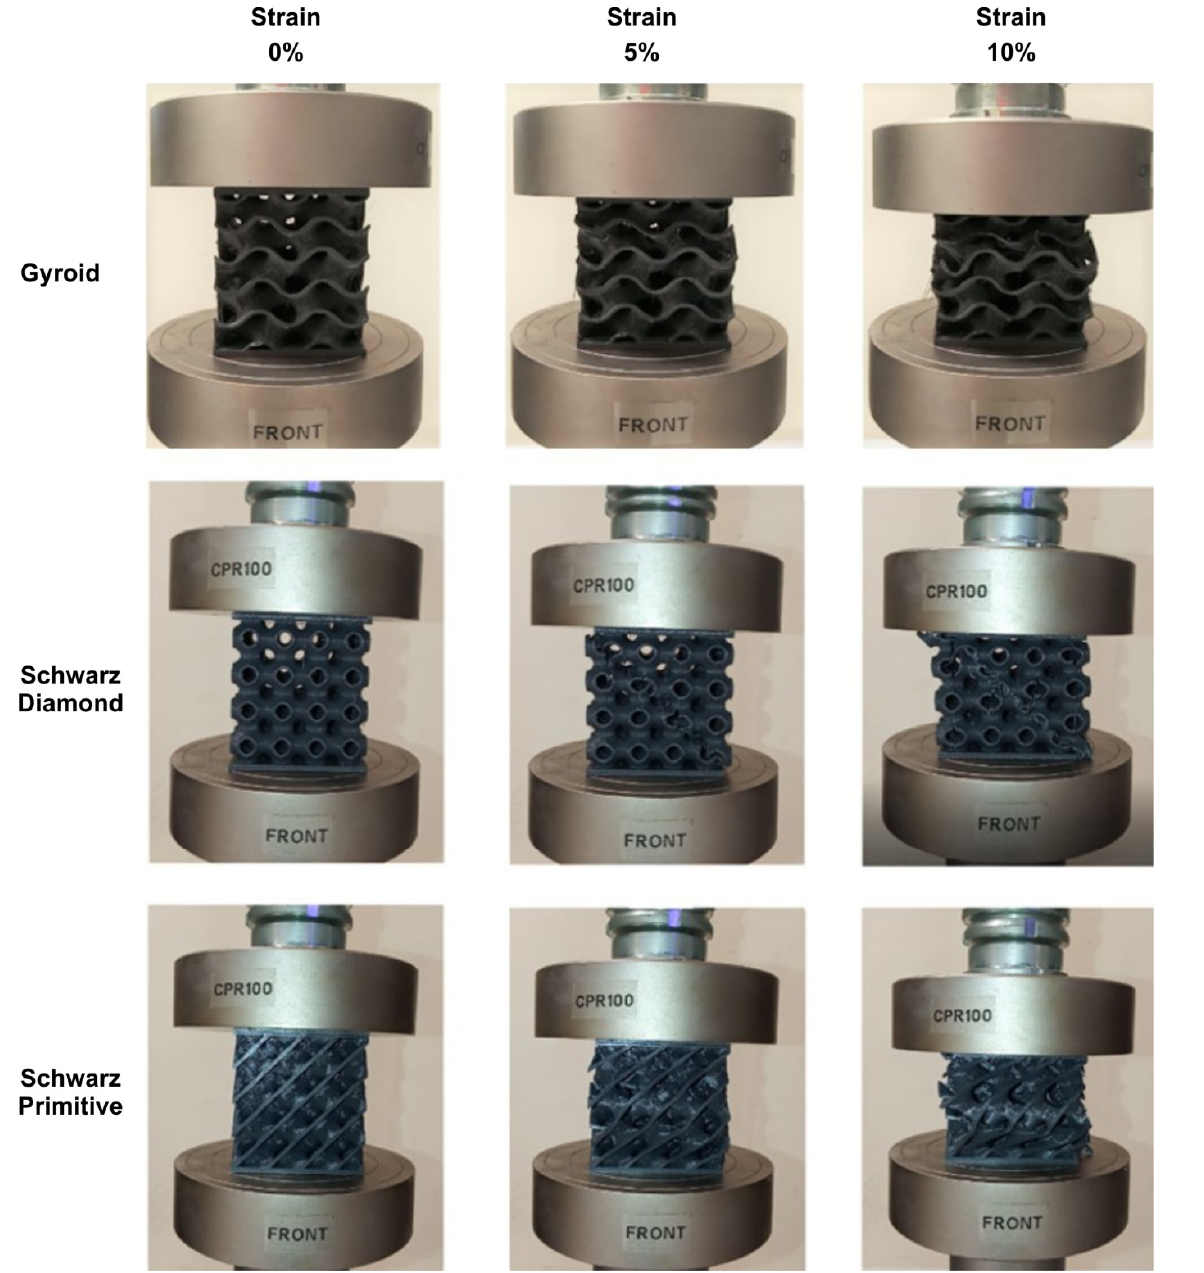
Figure 5. Comparison of deformation frames at 0%, 5% and 10% strain for 20% relative density Gyroid, Schwarz Diamond and Schwarz Primitive structures.